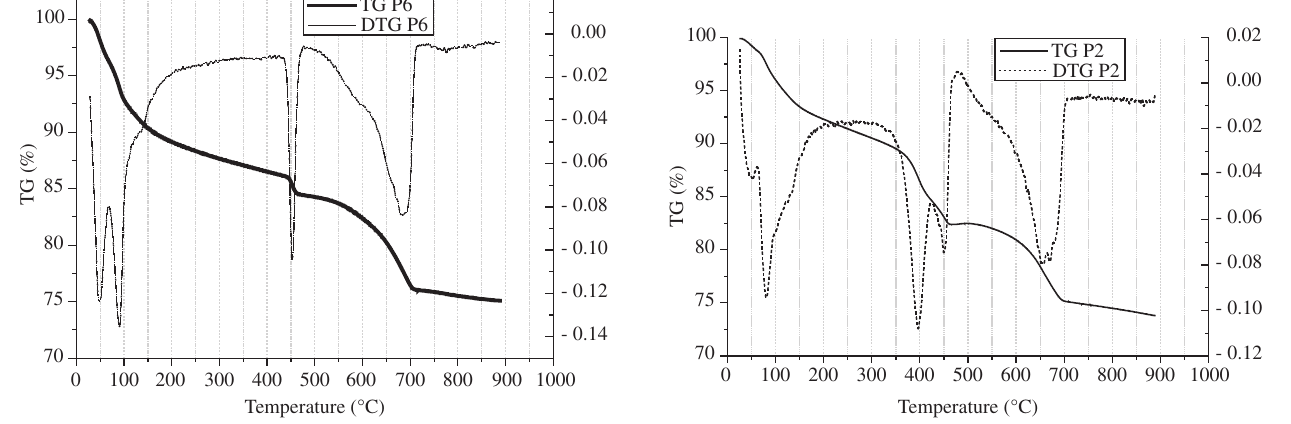
Figure 2. TG curve of the paste without polymer and 10% of silica fume P6.